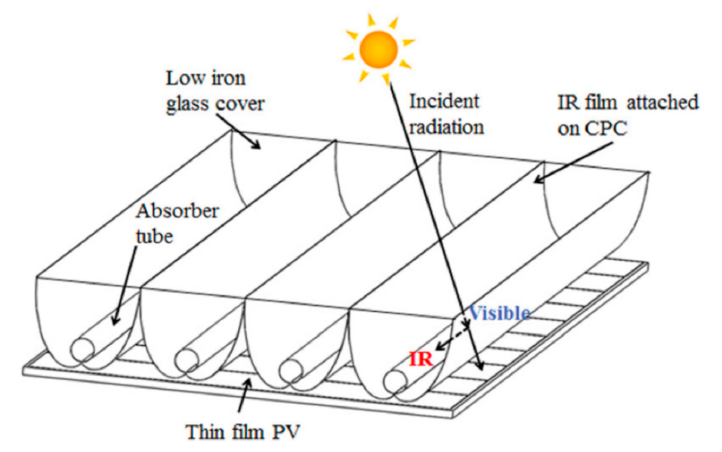
Figure 35. Hybrid photovoltaic (PV)/T CPC [69].